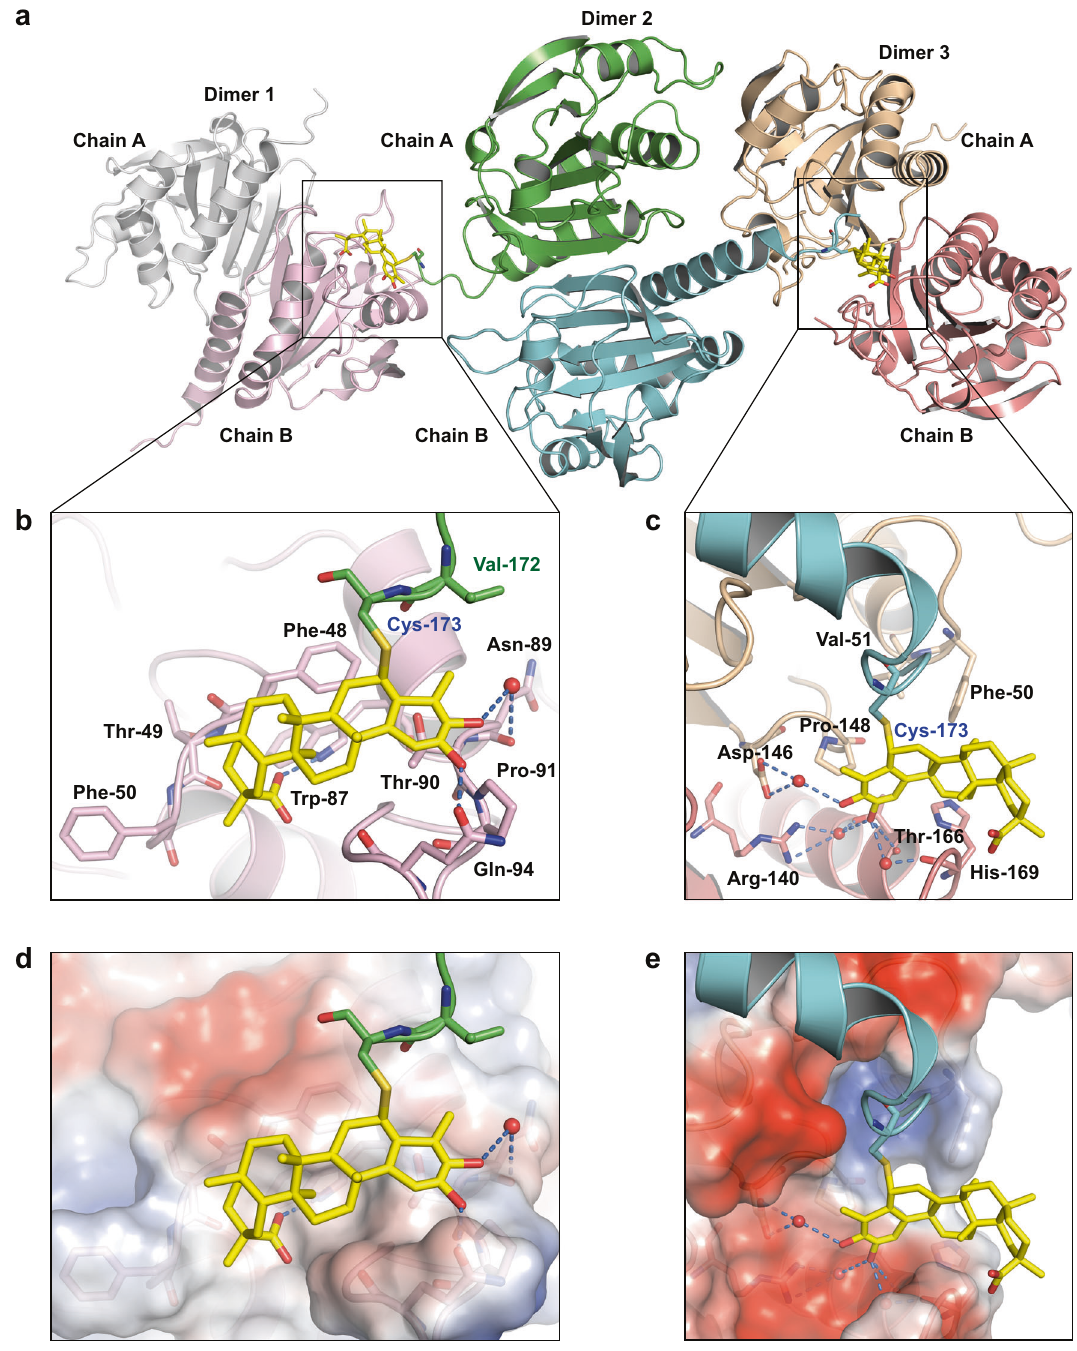
Fig. 3 Crystal structure of PRDX1 in complex with Celastrol. a Two Celastrol molecules are covalently linked to the two Cys-173 residues of one PRDX1 C52SC83S,1-175aa homodimer. Non-covalent binding was observed between these two Celastrol molecules and adjacent PRDX1 C52SC83S,1-175aa homodimers. b , c The non-covalent binding sites for two Celastrol molecules with adjacent PRDX1 C52SC83S,1-175aa homodimers. Celastrol is shown as yellow sticks. Hydrogen bonds are represented as blue dashed lines, and crystal water molecules were represented as red spheres. d , e Surface representation of the non-covalent binding sites of two Celastrol molecules. Electronegative region is colored in blue, while electropositive region is colored in red. Hydrogen bonds are represented as blue dashed lines, and crystal water molecules are represented as red spheres elevations in cellular ROS content were observed as compared to PRDX1 is a crucial antioxidant protein to regulate oxidative the DMSO control. The ROS-positive rates in colorectal cancer cell stress. 32 To determine whether Celastrol and compound 19-048 SW620 were 61.07% and 74.77%, and in HCT116 were 88.4% and impact the cellular redox state via targeting PRDX1, ROS levels 91.7% after treatment with Celastrol or compound 19-048 for 24 h were measured by dichlorodihydro fl uorescein diacetate (DCFH- at 2 μ M. Treatment with the antioxidant agent N-acetyl-L-cysteine DA) probe staining in SW620 and HCT116 cells. After treatment of (NAC) 33 in SW620 and HCT116 cells completely suppressed the Celastrol and compound 19-048 at different concentrations, sharp Signal Transduction and Targeted Therapy (2023)